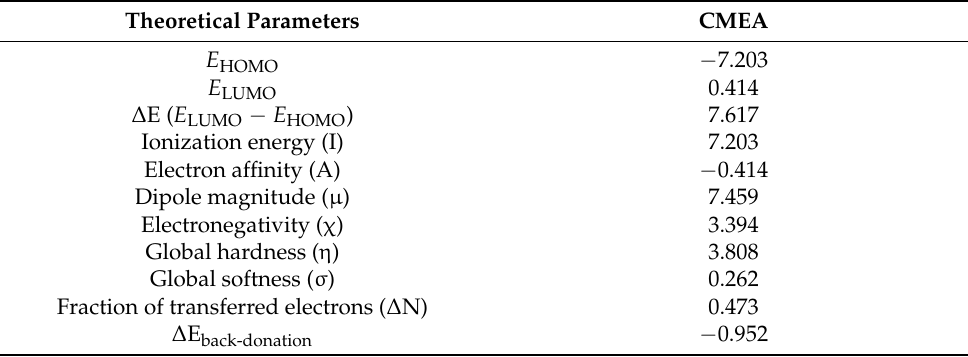
Table 7. Theoretically evaluated quantum chemical variables of the CMEA